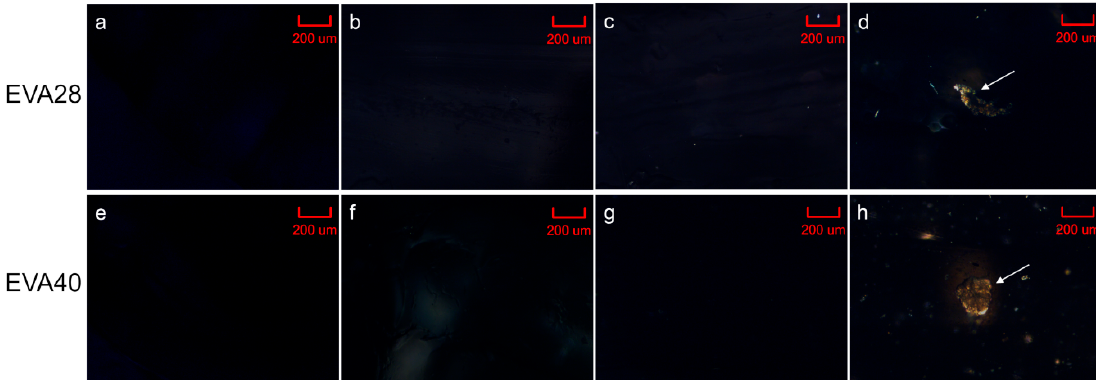
Figure 3. Hot-stage polarized light microscopy images recorded at 90 °C; ( a ) ethylene-vinyl acetate 28 (EVA28), ( b ) EVA28 + 4 wt.% progesterone (P4), ( c ) EVA28 + 5 wt.% P4, ( d ) EVA28 + 6 wt.% P4, ( e ) EVA40, ( f ) EVA40 + 5 wt.% P4, ( g ) EVA40 + 6 wt.% P4 and ( h ) EVA40 + 7 wt.% P4. Arrows indicate